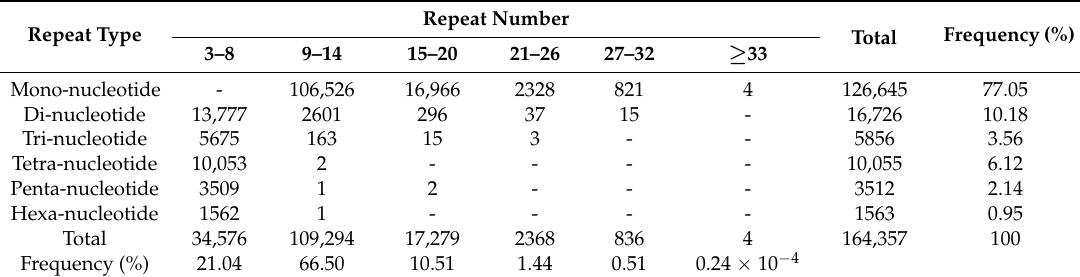
Table 1. Distribution of the SSR loci in the genome of Betula alnoides .